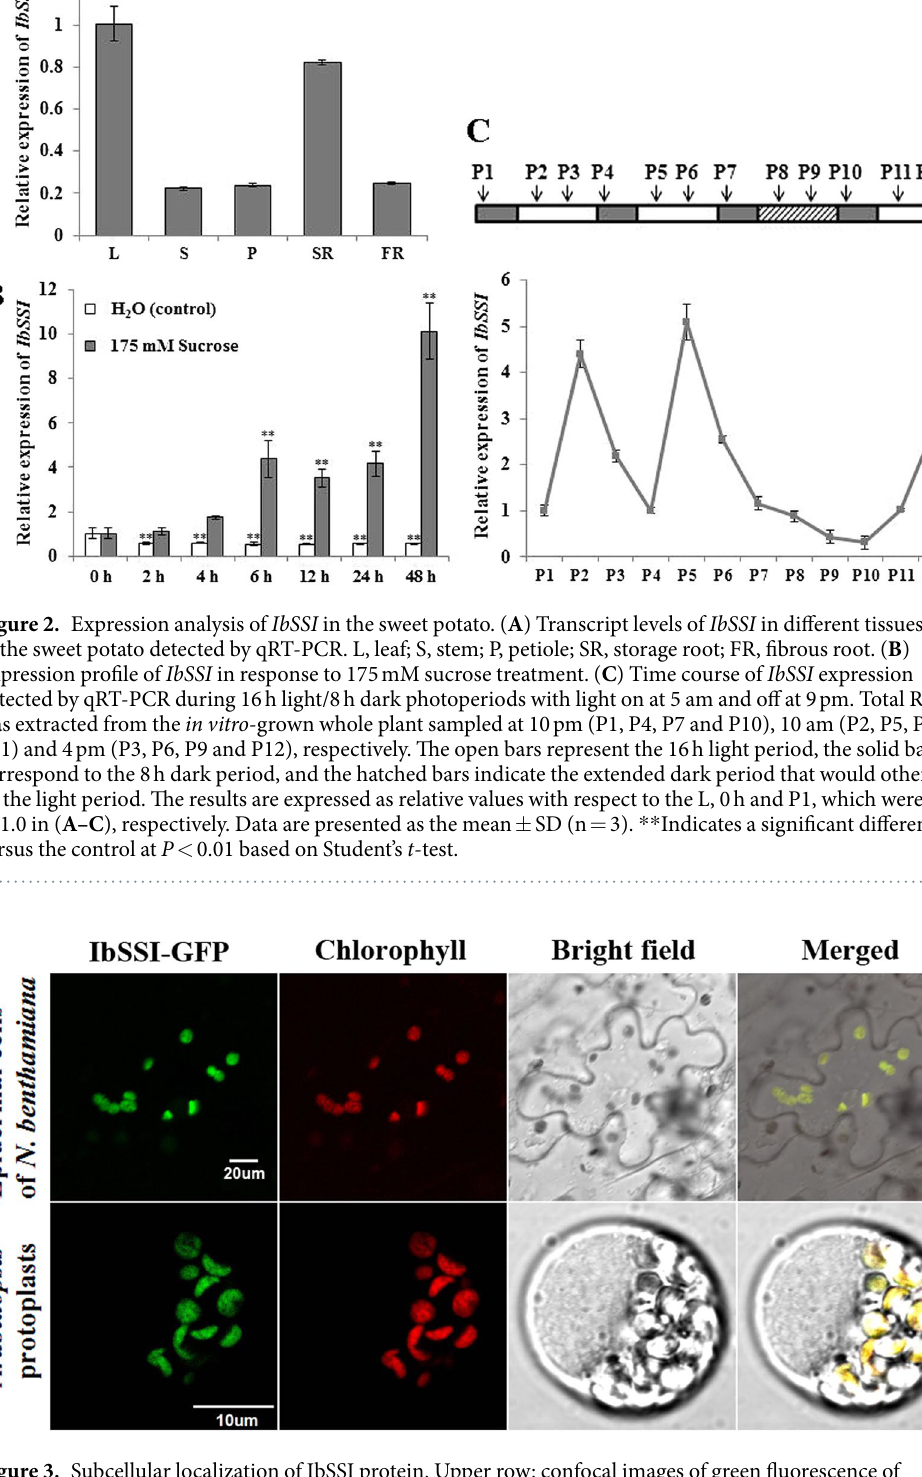
The amount of SSI protein increased in the overexpression lines, whereas the two RNAi lines showed no detectable abundance of SSI protein. The other granule-bound proteins remained unchanged in the transgenic lines.